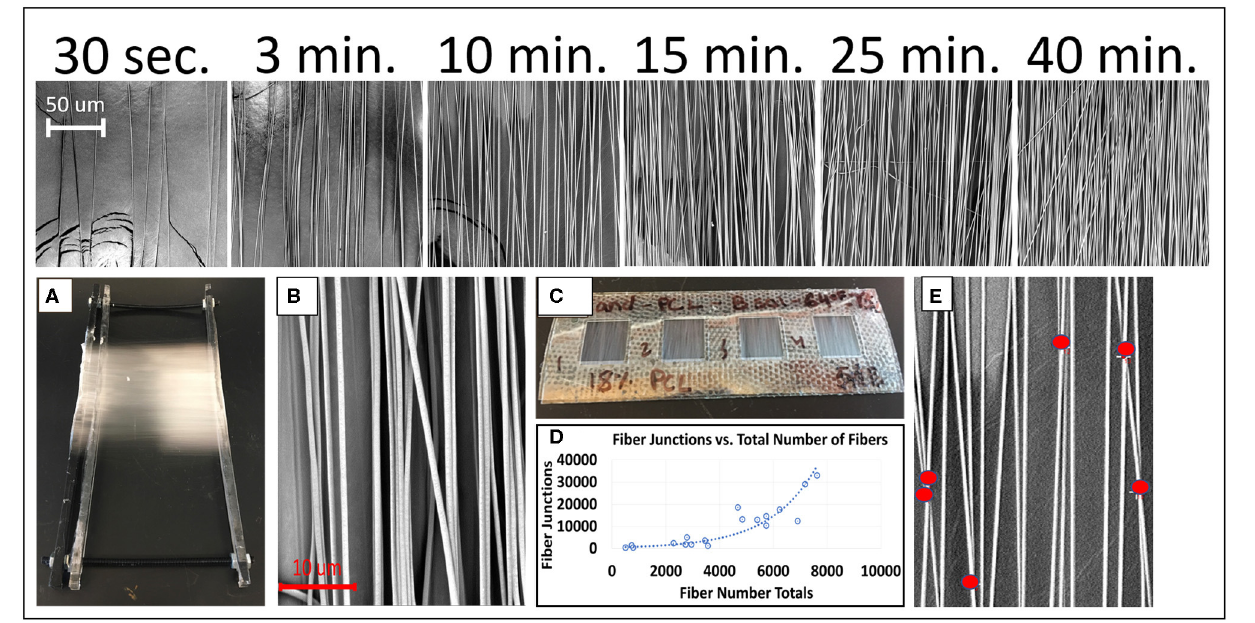
FIGURE 2 | (Top) Representative electrospun PCL nanofibers by electrospinning duration captured at 1,500x magnification. (A) PCL nanofibers adhered to collection tray. (B) SEM image of electrospun fibers at 8,000x magnification specifically used for measuring fiber diameters. (C) Close up of 10 × 10mm plastic window squares